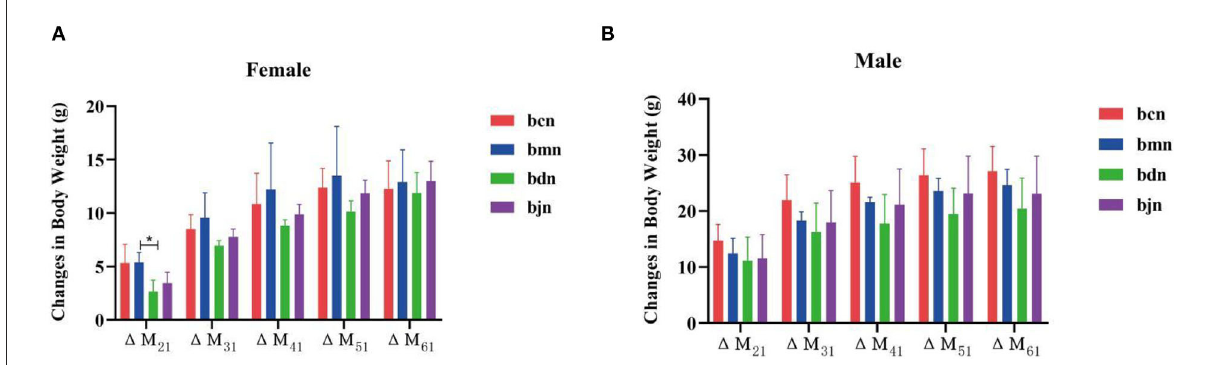
FIGURE2 Effects of DO on the changes in body weight of mice fed high-fat diet. Data were mean ± SD, n = 6, * p < 0.05. 1 M 21 = body weight of mice on the 7th day-body weight of mice on the 0th day; 1 M 31 = body weight of mice on the 14th day-body weight of mice on the 0th day; 1 M 41 = body weight of mice on the 21th day-body weight of mice on the 0th day; 1 M 51 = body weight of mice on the 28th day-body weight of mice on the 0th day; 1 M 61 = body weight of mice on the 35th day-body weight of mice on the 0th day. bcn: normal saline-treated basal diet group; bmn: normal saline-treated high-fat diet group; bdn: DO traditional decoction-treated high-fat diet group; bjn: lipid-lowering decoction-treated high-fat diet group. (A) Weight changes of female mice. (B) Weight changes of male